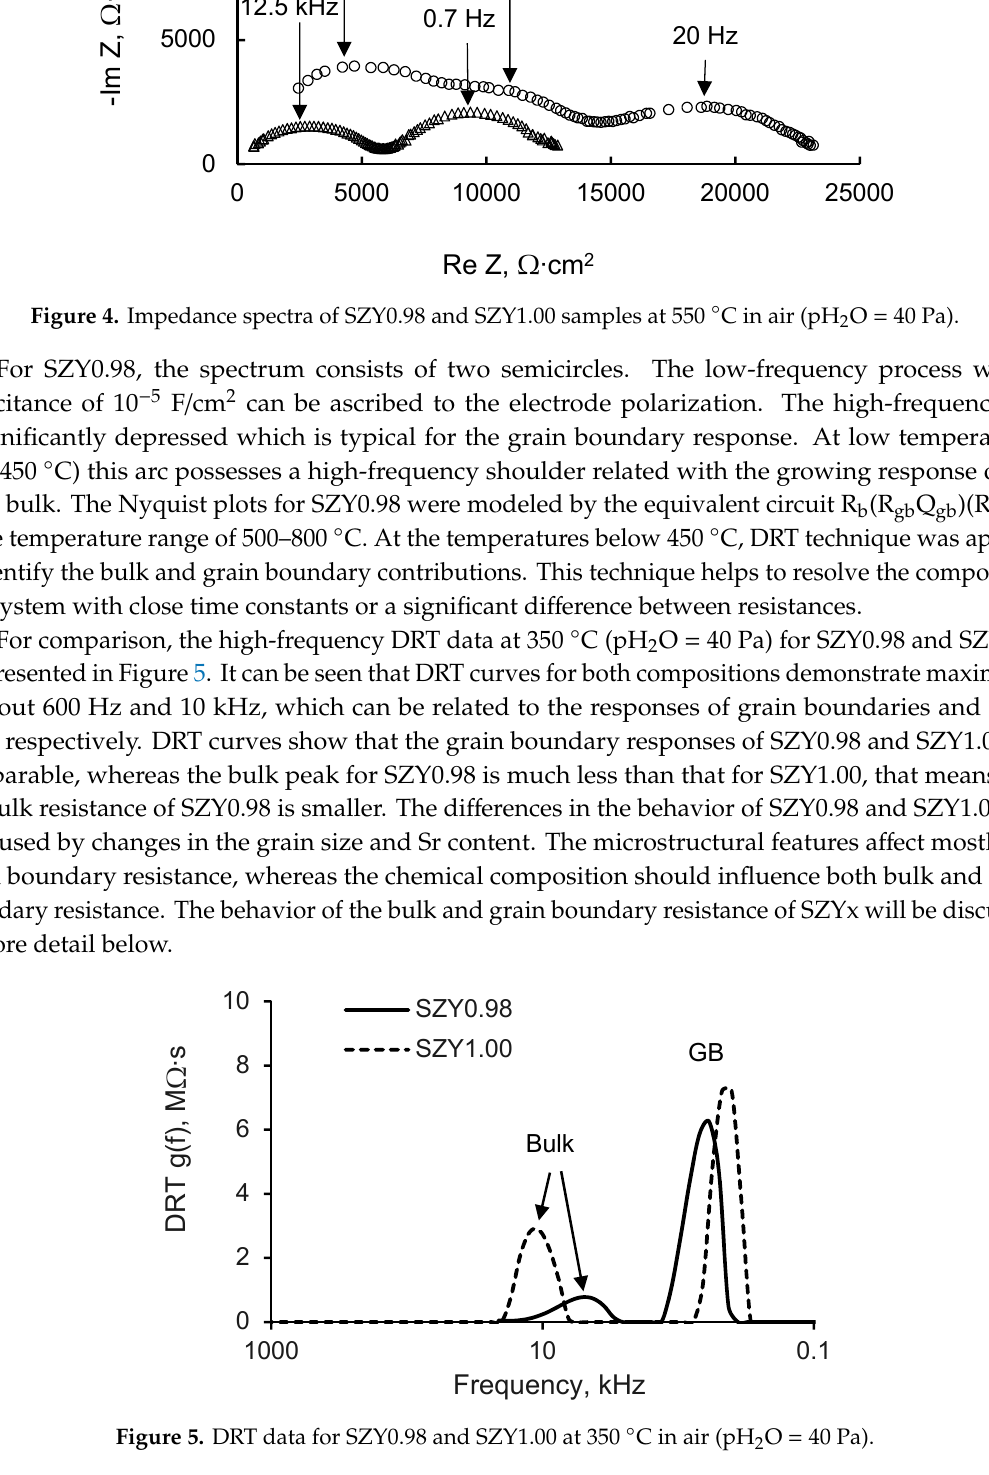
Figure 5. DRT data for SZY0.98 and SZY1.00 at 350 °C in air (pH 2 O = 40 Pa).